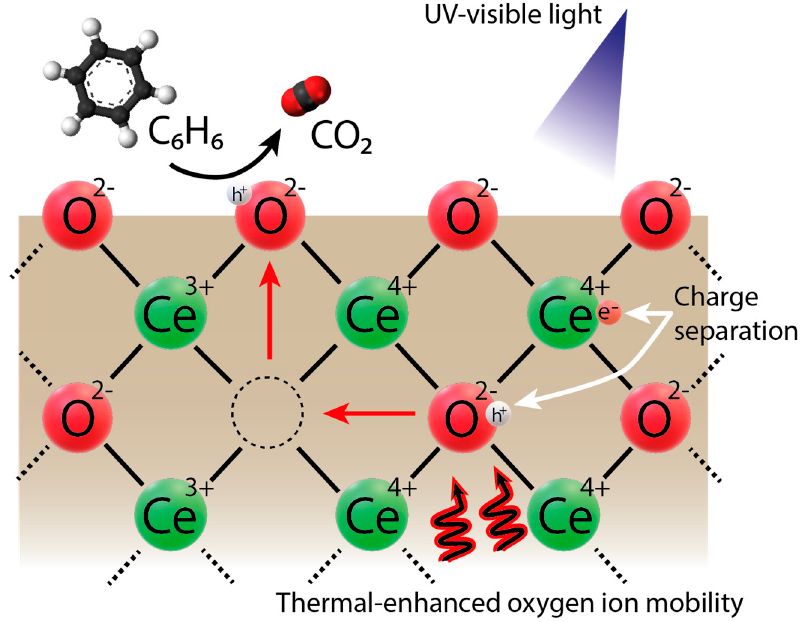
Schematic CeO 2 structure remarking the presence of OV and h + / e − separation. Plasmon-photothermal induced local heating in CeO 2 structure also enhances the oxygen ion mobility, facilitating the migration of O 2 − (h + ) species to the catalyst surface and, thus, enhancing the reaction (adapted from [89]).